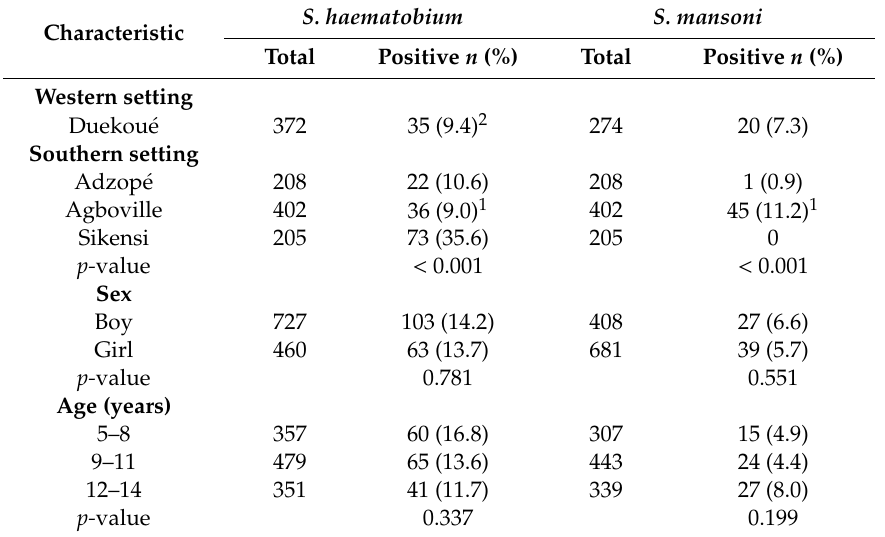
Table 2. Prevalence rate of Schistosoma haematobium and Schistosoma mansoni infection, stratified by study settings, sex, and age group among schoolchildren from C ô te d’Ivoire in early